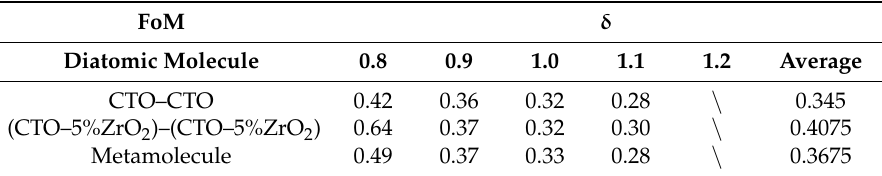
Table 2. Figure of merit (FoM) of CTO “homonuclear diatomic molecule”, CTO–5%ZrO 2 “homonuclear diatomic molecule”, and metamolecule with various distances δ and their average values of these distances.